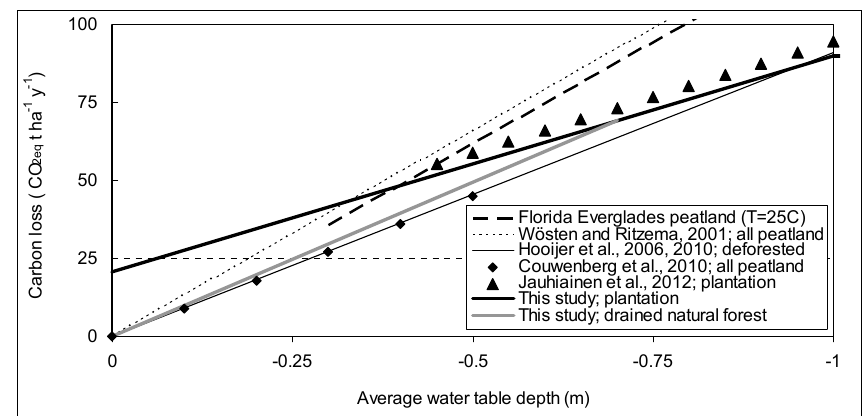
Fig. 7. Comparison of the relation between carbon loss (CO 2eq ) and water table depth in tropical peatlands, more than 5yr after drainage, as determined in this and other studies. The Florida Everglades relation is calculated from data in Stephens and Speir (1969), that may also have been used to calculate the relation in W¨osten and Ritzema (2001). The relations by Hooijer et al. (2006, 2010) and Couwenberg et al. (2010) were based on partly different sets of literature sources. The relation by Jauhiainen et al. (2012) is based on daytime CO 2 flux measurements in the same Acacia plantation as the current study, excluding root respiration and corrected for diurnal temperature